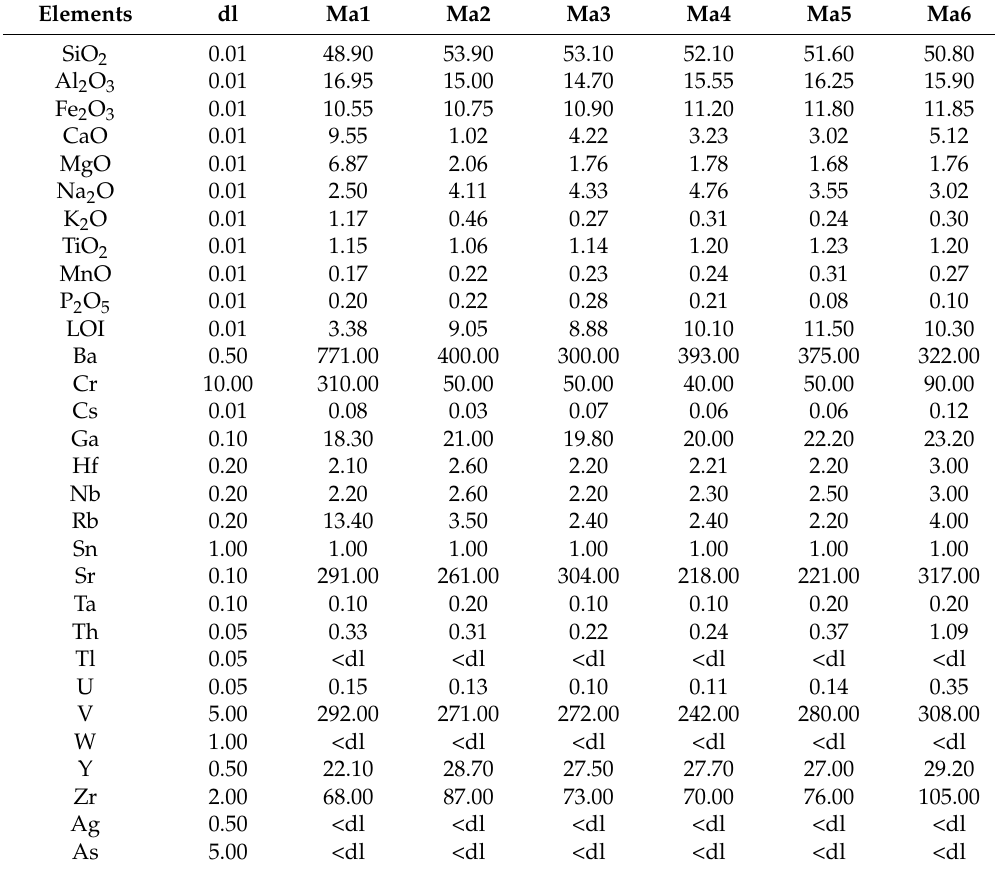
Er (2.50 mg/kg) and Yb (2.21 mg/kg) (Table 1). The REE normalised to chondrite according to McDonough and Sun [22], and, as shown in Figure 3, revealed moderate LREE enrichment and slight HREE enrichment. The Ce/Ce* and Eu/Eu* ratio values are close to 1 (Table 1). The (La/Yb) N ratio is very low (1.48). Table 1. Major element (wt %), trace element (mg/kg) and rare-earth elements (REE) (mg/kg) contents obtained by geochemical analysis for the soil profile samples in the Maroua region